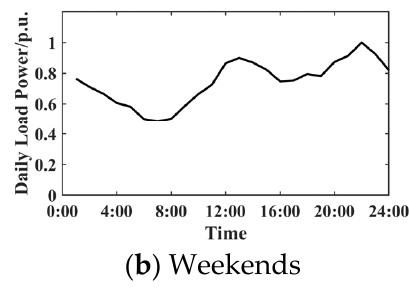
Figure 7. Typical daily load power in residential areas. Table 3. Priority of EV access nodes in each power distribution area.